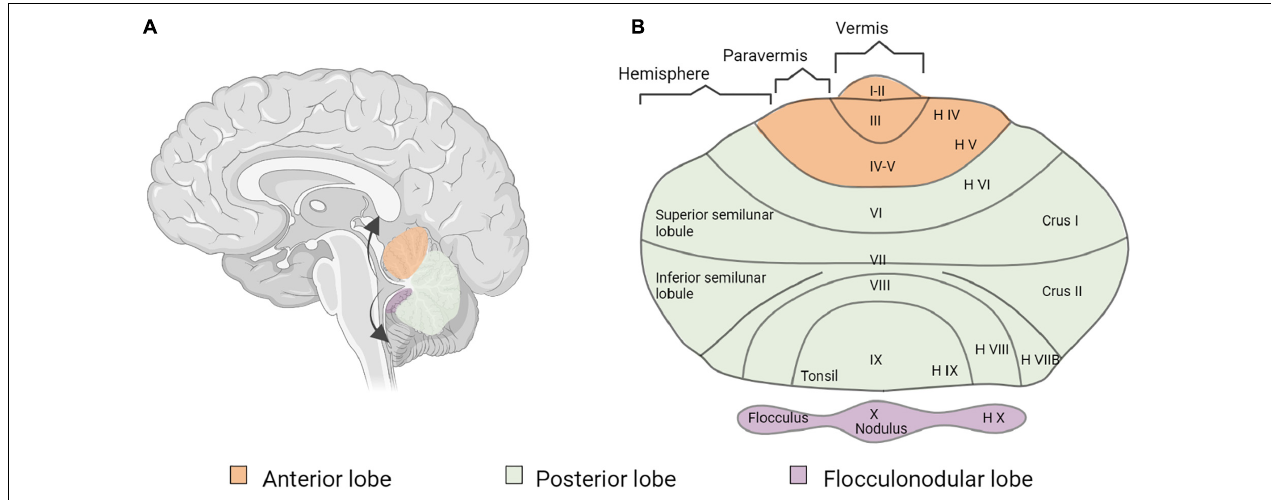
FIGURE 6 | Cerebellar anatomy. (A) Sagittal section of the human brain and cerebellum. The arrows show the way the cerebellum is unfolded. (B) Flatmap representation of the unfolded cerebellum, using both the classification of Larsell (1952) and the classical nomenclature of the human cerebellum (Malacarne, 1791; Reil, 1808; Burdach,